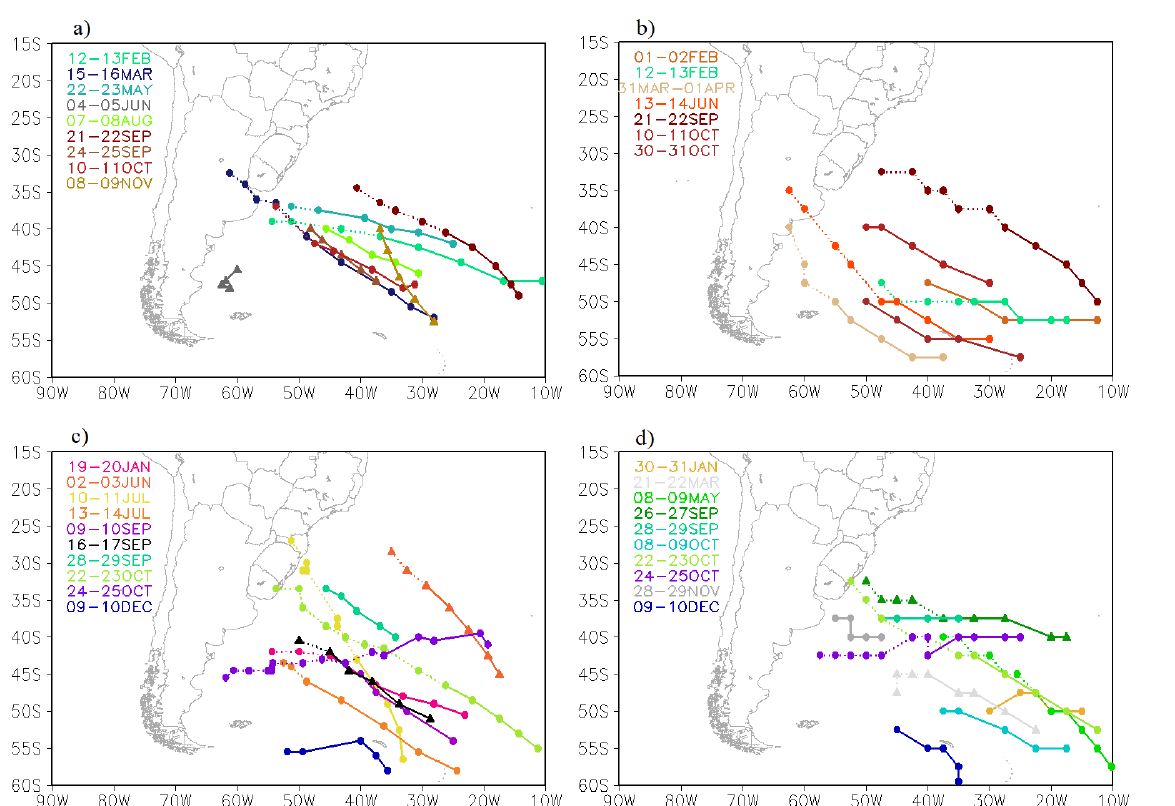
Figure 2. Trajectories of moderate explosive cyclones (dashed lines – non-explosive phase; solid lines – explosive phase): a) MERRA-2 in 2014; b) NCEP2 in 2014; c) MERRA-2 in 2015; d) NCEP2 in 2015. Systems with solid circle trajectories are common cases of the two reanalyses, while those with solid triangle trajectories are cases only of the presented